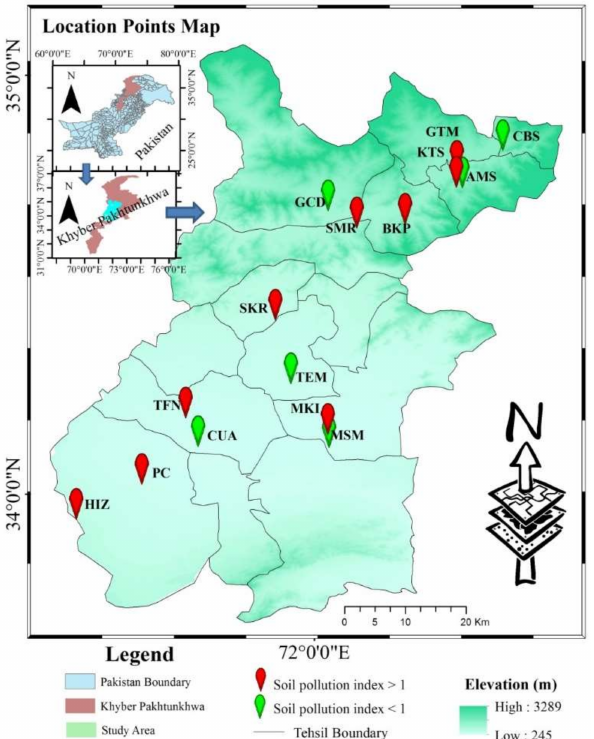
Figure 1. Study area map along with sampling point for collection of plant and soil samples in abandoned sites of Khyber Pakhtunkhwa, Pakistan. Note: KTS (Kanju Town Junction), GTM (GT Road Mingora), SKR (Skhakot Road), SMR (Shamozu Road), PC (Peshawar), HIZ (Hayatabad Industrial Zone), MKI (Mardan Kid Industry), BKP (Barikot Crush Plant), CUA (Charsadda Urban), MSM (Mardan Shiekh Malton), TFN (Tarnab Form), TBM (Takht Bhai), GCD (Gulabad College Degree), AMS (Amankot), CBS (Charbagh